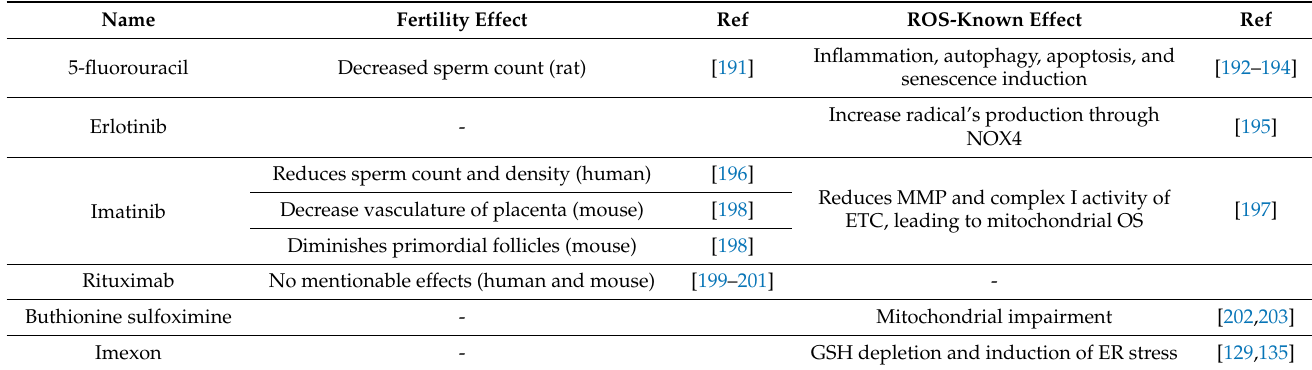
Table 2. Other anticarcinogenic agents and their effects on